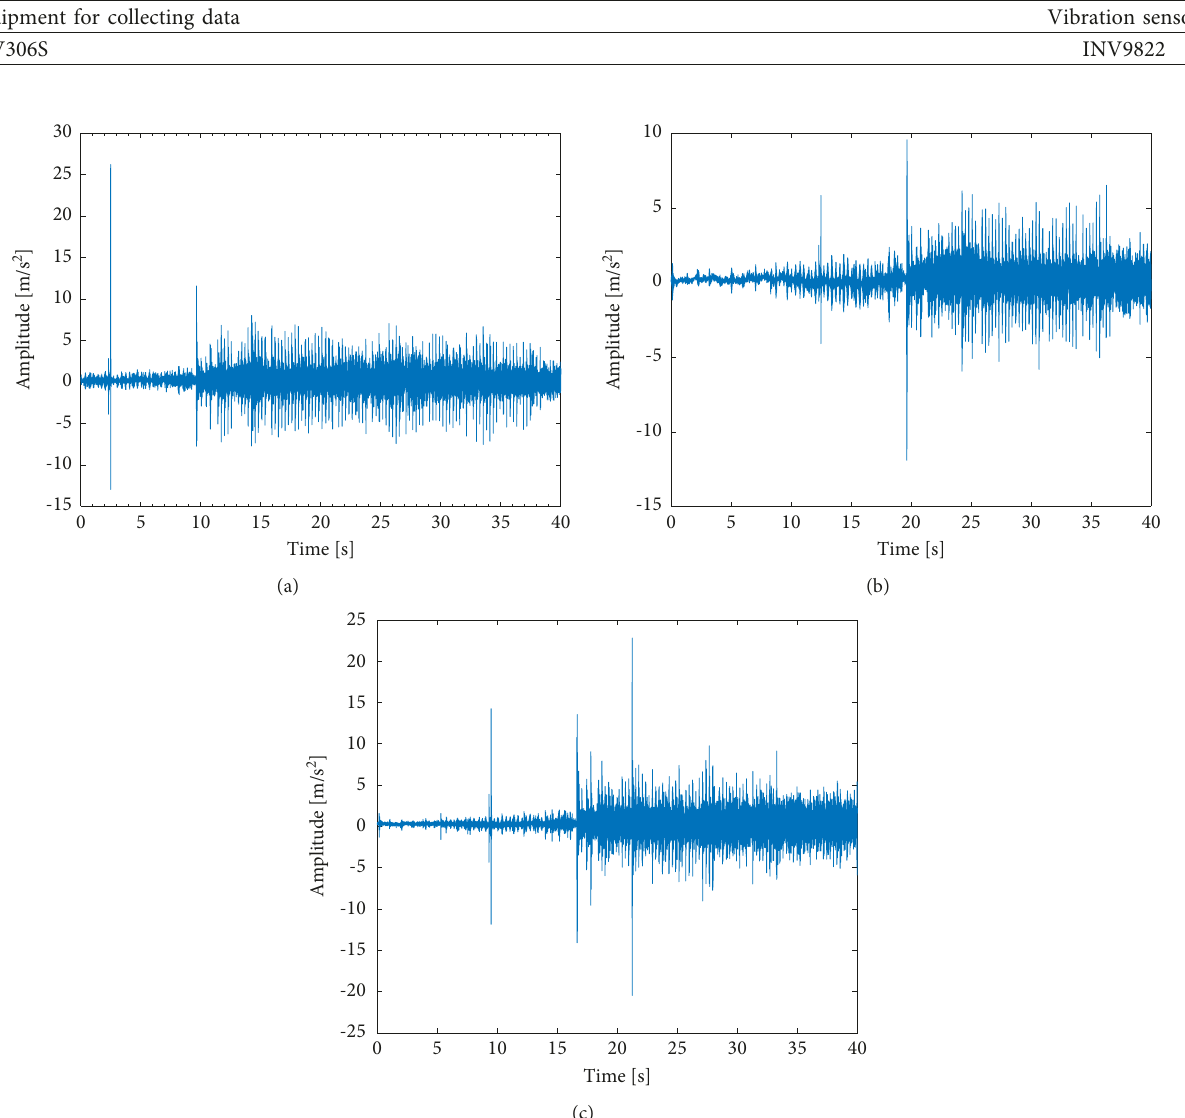
Figure 7: Time-domain signals of the vibration of coke pusher. (a) X -direction. (b) Y-direction. (c) Z